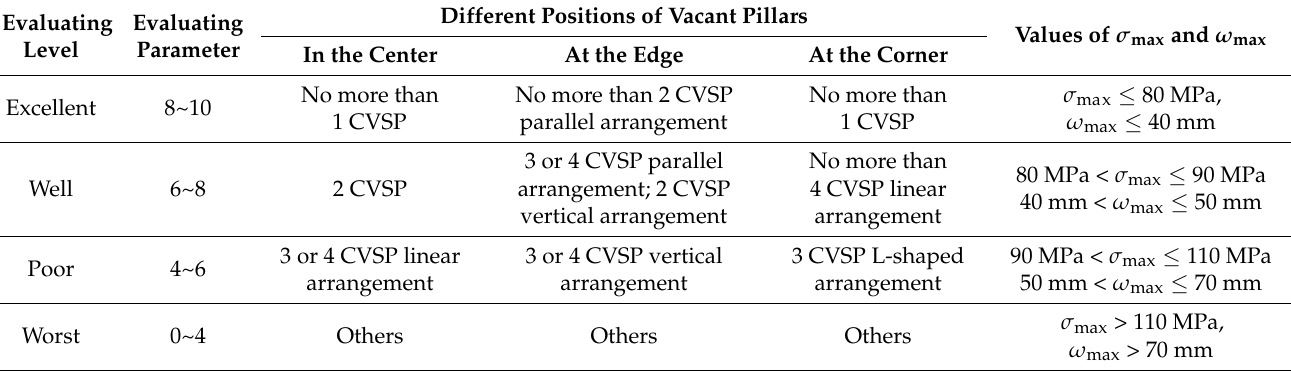
Table 3. Vacant Pillar Evaluation basis [18].